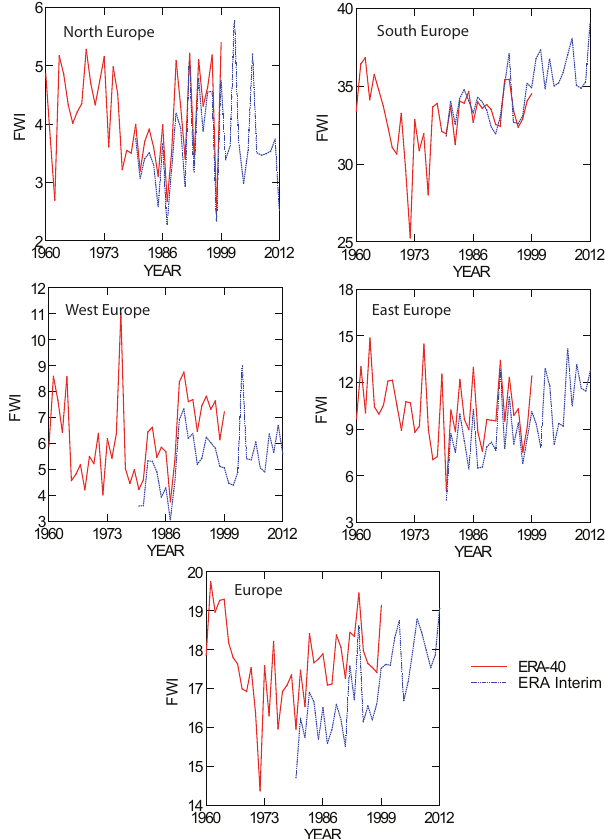
Figure 2. The year-to-year variation of March–September mean FWI from ERA-40 and ERA Interim data sets for four selected areas (see Fig. 1) and for the whole of